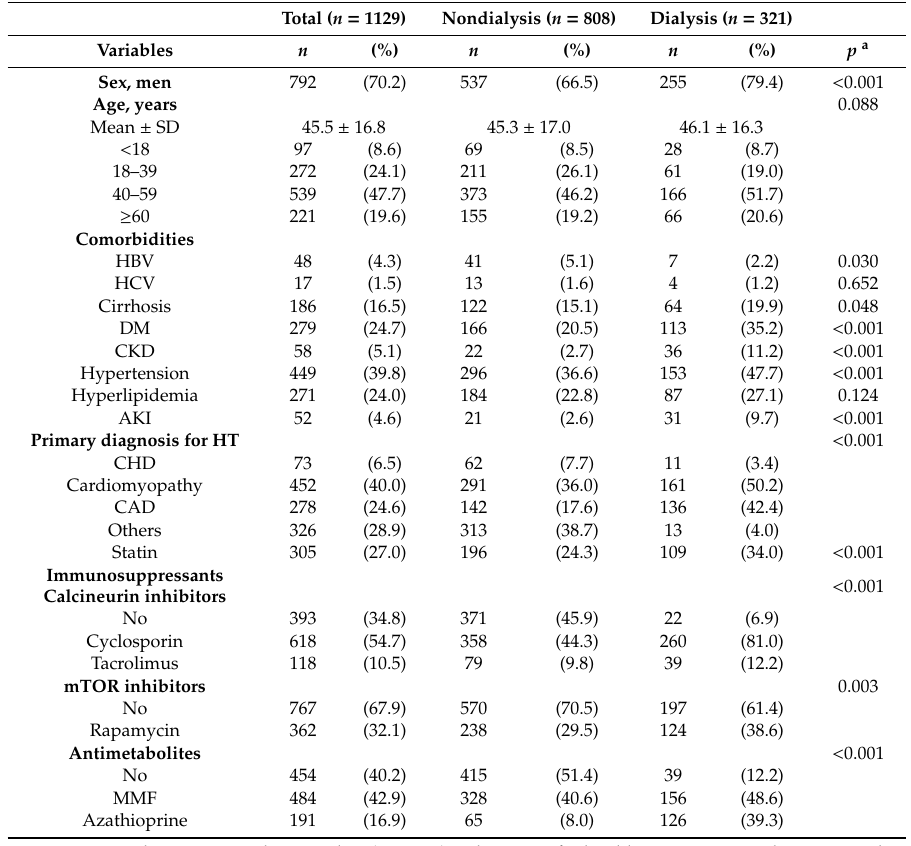
Table 1. Demographic and clinical characteristics between HT recipients with or without